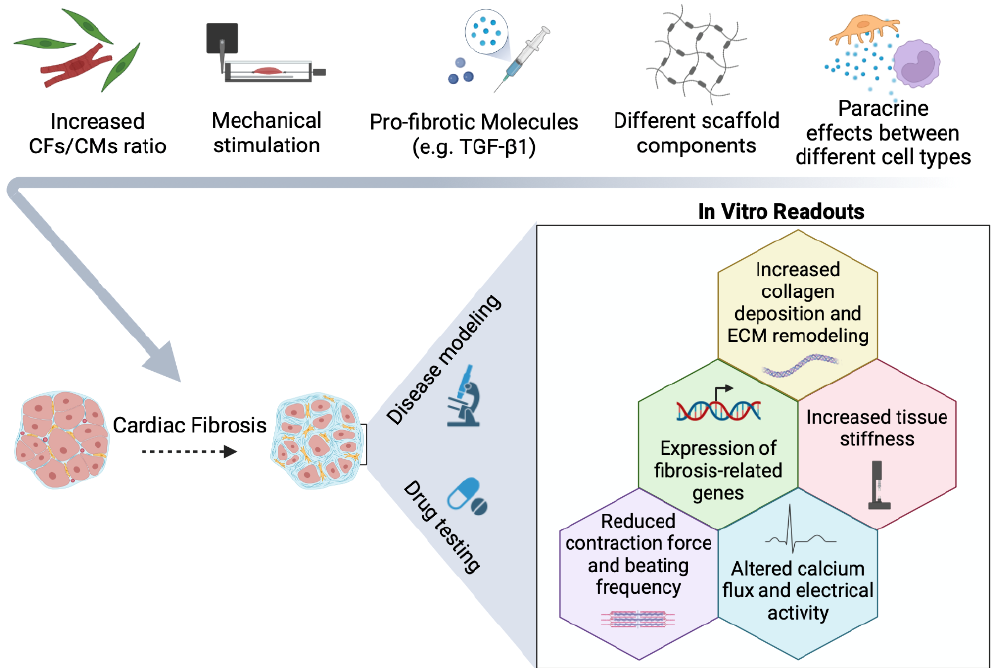
Figure 3. Tuneable parameters for simulating cardiac fibrosis. The application of different stimuli (e.g., pro-fibrotic molecules, mechanical stress, and variation of cellular composition) in multicellular 3D models allow features of cardiac fibrosis to be mimicked in vitro, which can be assessed and quantified by multiple in vitro readouts. Cardiac fibroblasts (CFs); cardiomyocytes (CMs). This figure was created with Biorender software.